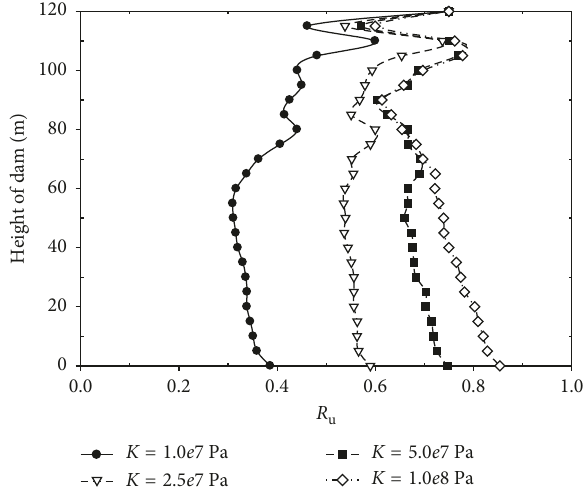
Figure 8: Comparing the displacement values in the middle of the core for different bulk modulus of